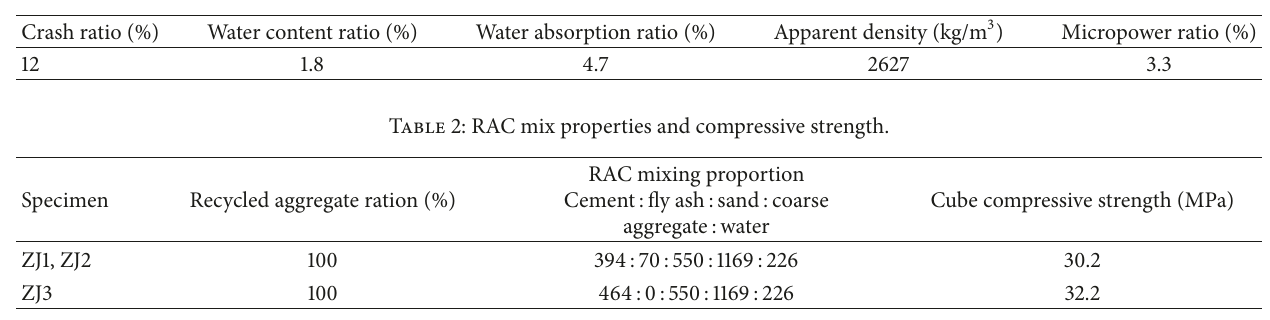
Table 1: Basic performance indexes of the recycled aggregate.